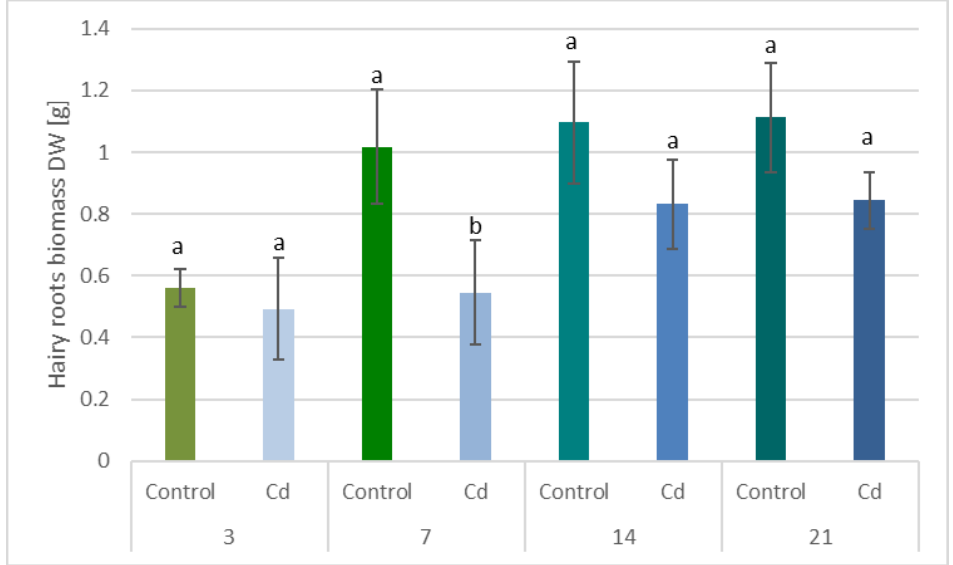
Figure 1. The time-dependent effect of cadmium ions on hairy roots biomass. Bars which do not share a common letter are significantly different ( p < 0.05).